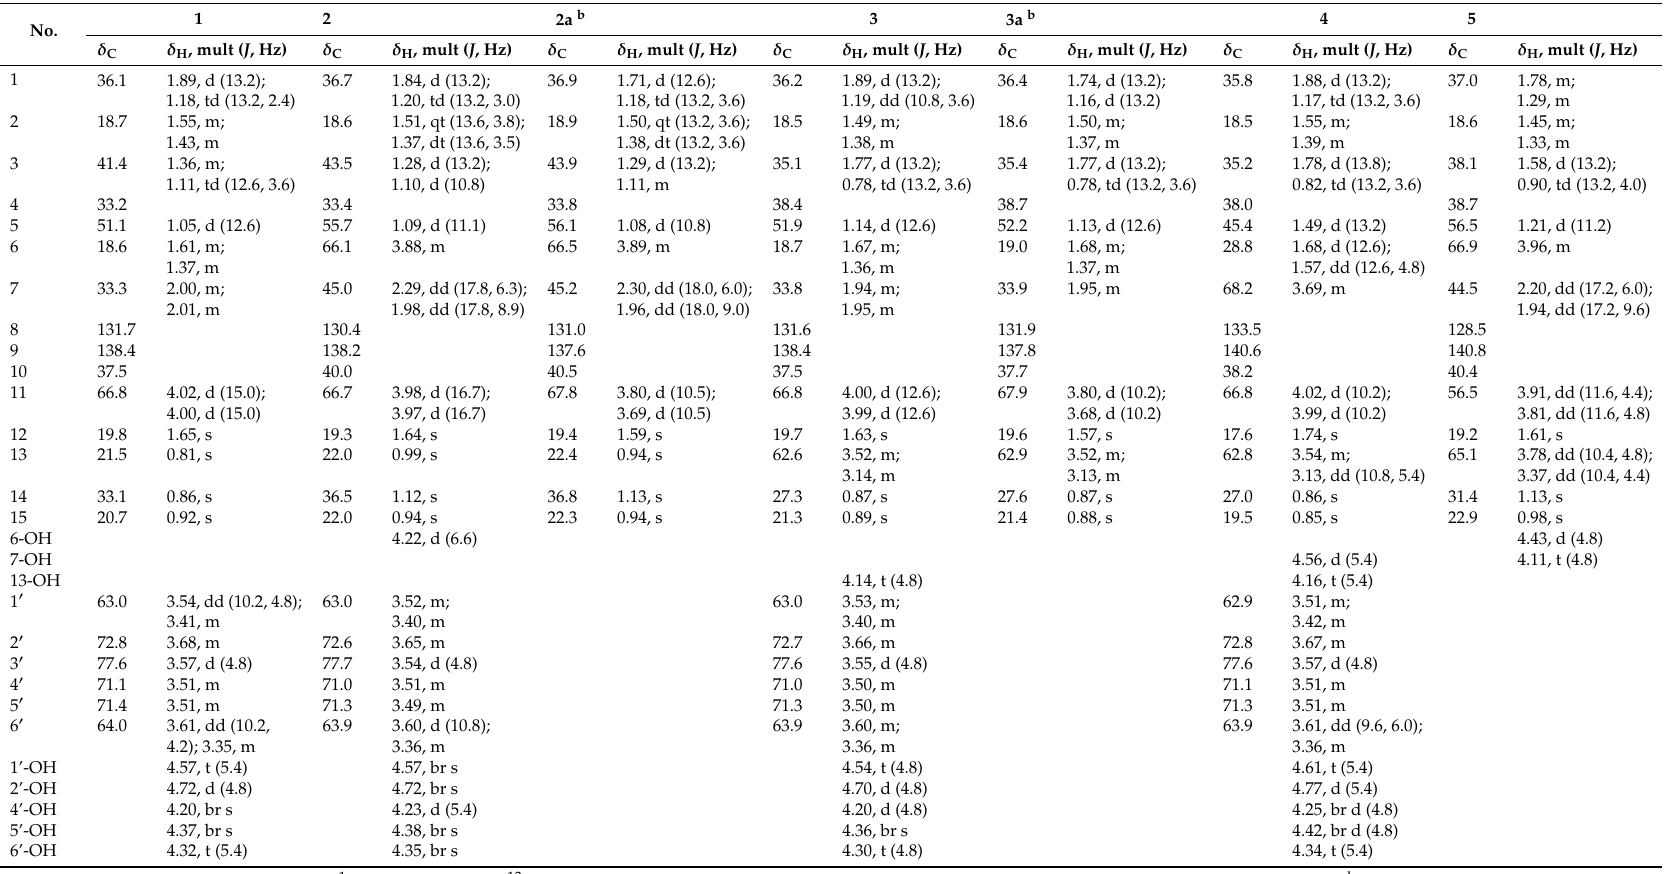
Table 1. NMR spectroscopic data of 1 – 5 a